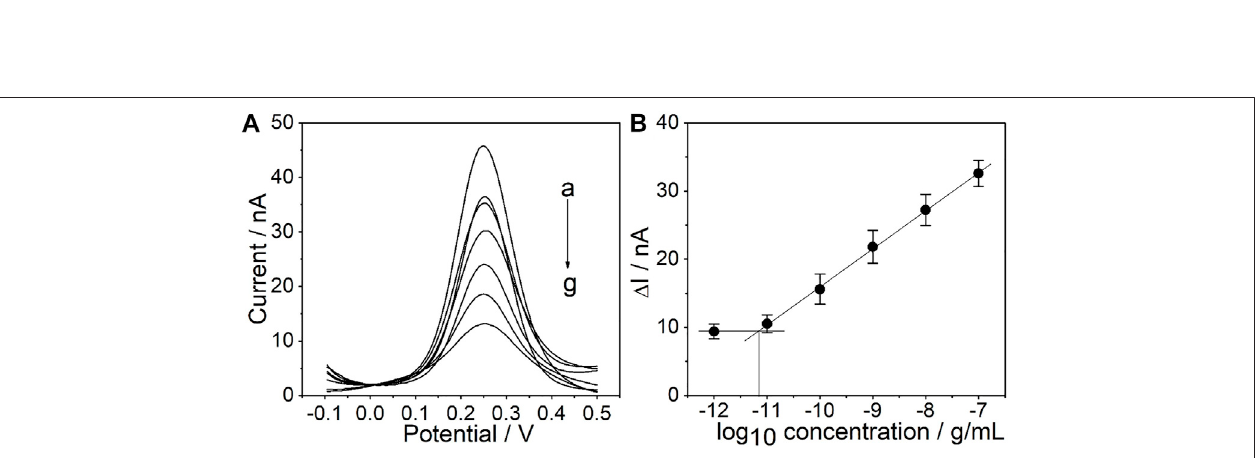
FIGURE 5 | (A) SWV curve of the Pt μ E/Au aptasensors for CEA, (a) without CEA, (b) 10 – 12 g/ml, (c)10 – 11 g/ml, (d) 10 – 10 g/ml, (e) 10 – 9 g/ml, (f) 10 – 8 g/ml, and (g) 10 – 7 g/ml; (B) SWV calibration plot of Pt μ E/Au aptasensors recorded for [CEA] range from 10 – 12 g ml − 1 to 10 – 7 μ g ml − 1 .